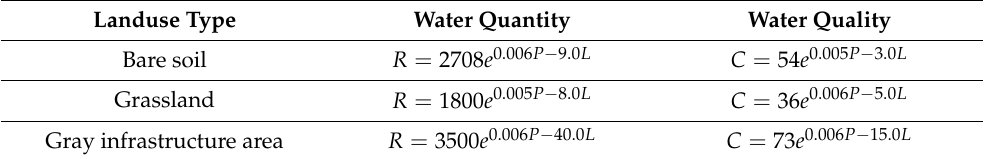
Table 1. The objective function for water quantity and quality under various land-use